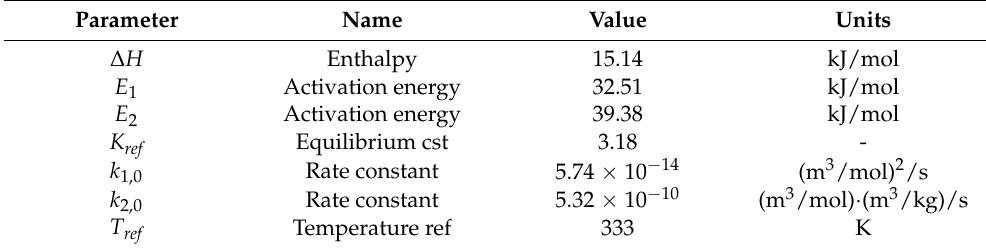
Table 2. Values of rate constant parameters used in simulation for LA-ESR reaction